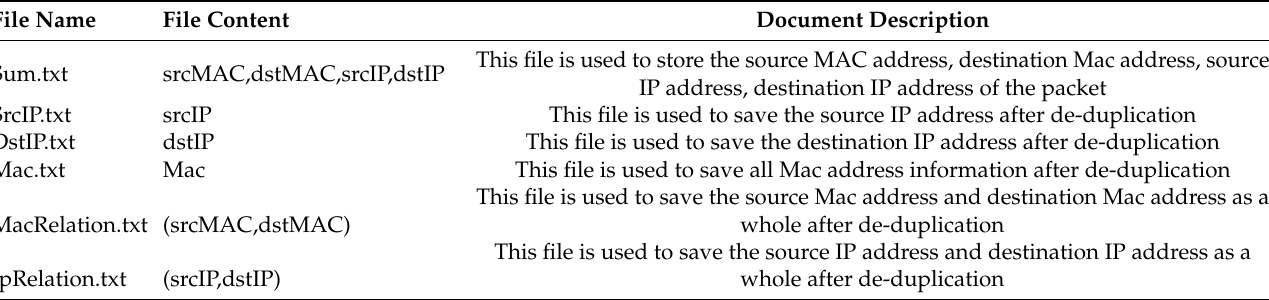
Table 2. Description of Intermediate Documents.